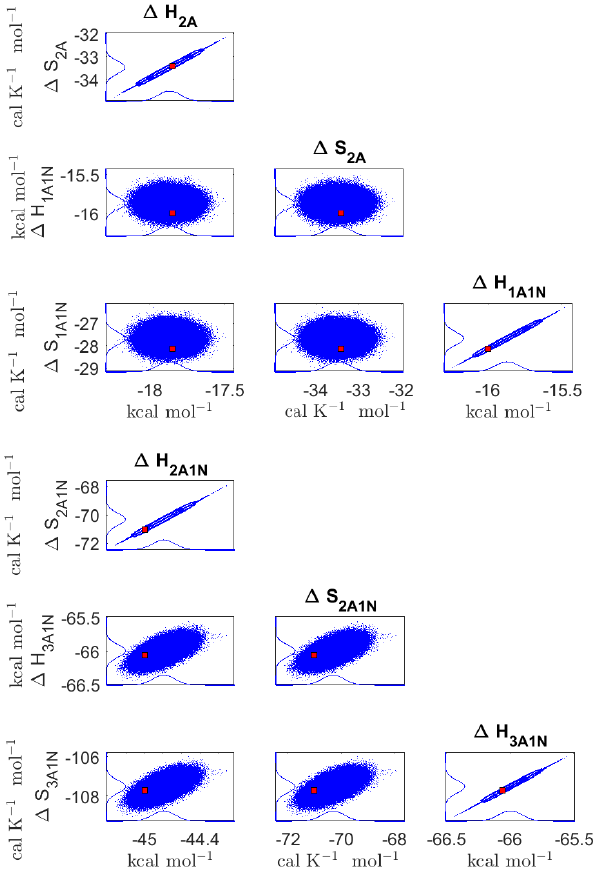
Figure D4. Pairwise marginal posterior distributions (for param- eter indexes ranging from 17 to 24) of the cluster formation en- thalpies and entropies determined from steady-state cluster con- centration measurements at two temperatures ( T = 278K and T = 292K). Red rectangles denote the baseline values from Olenius et al. (2013b) used to generate the synthetic data. Here, the symbols (cid:49) H and (cid:49) S stand for cluster formation enthalpies and entropies, re- spectively. The notation xAyN corresponds to a cluster with x sul- furic acid and y ammonia